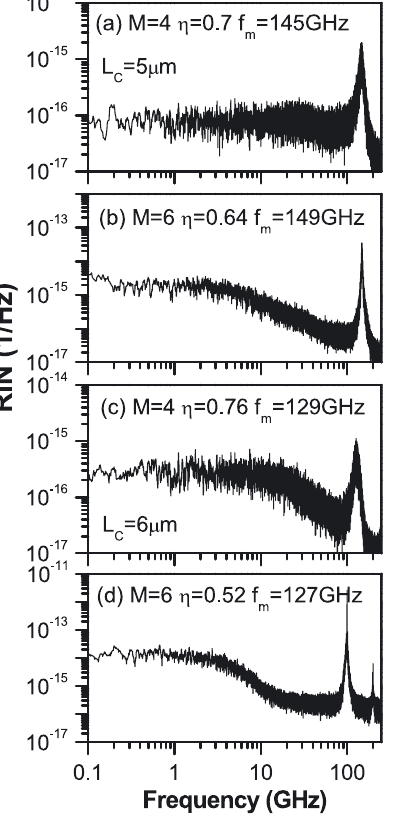
Figure 8: RIN spectra of MTCC-VCSEL with L C = 5 μ m when (a) M = 4, η = 0.7, f η = 0.64, f m = 145 GH, (b) M = 6, m = 149 GHz, and of MTCC VCSEL with L C = 6 μ m when (c) M = 4, η = 0.76, f m = 129 GHz, and (d) M = 6, η = 0.52, f m = 127